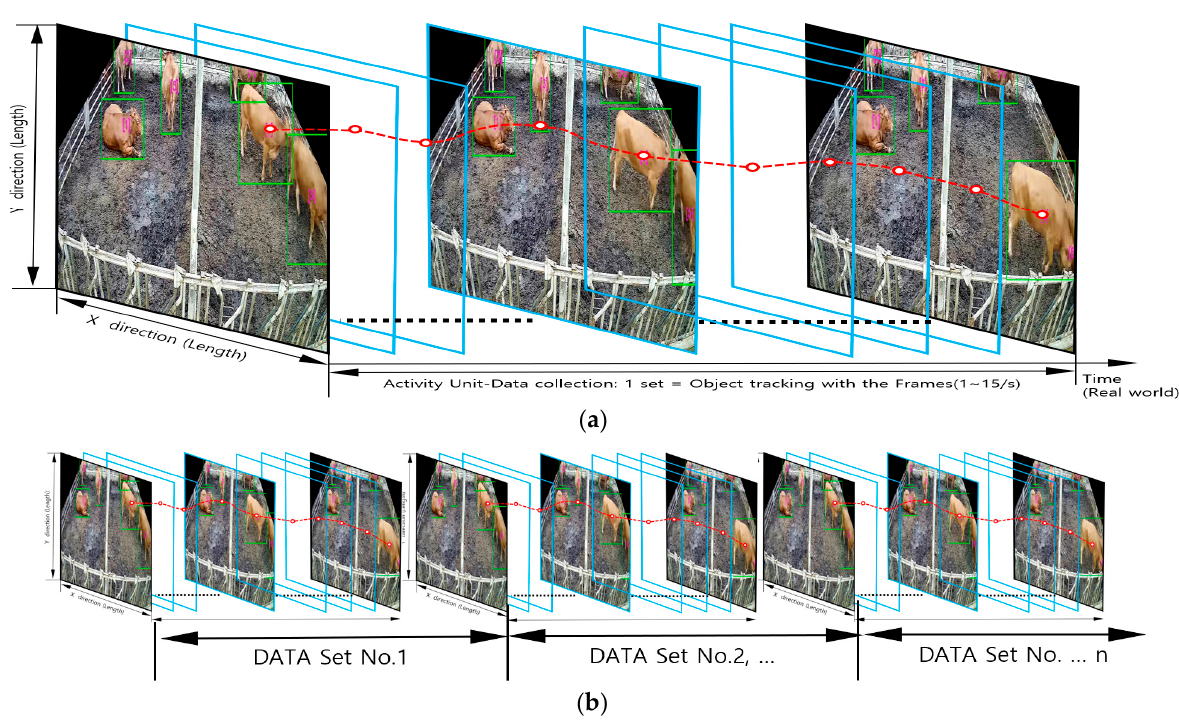
Figure 6. Data collection and processing of each individual Hanwoos location and activity data with image frames: ( a ) collection of activity unit-data sets; ( b ) total accumulated activity data using unit-data sets.